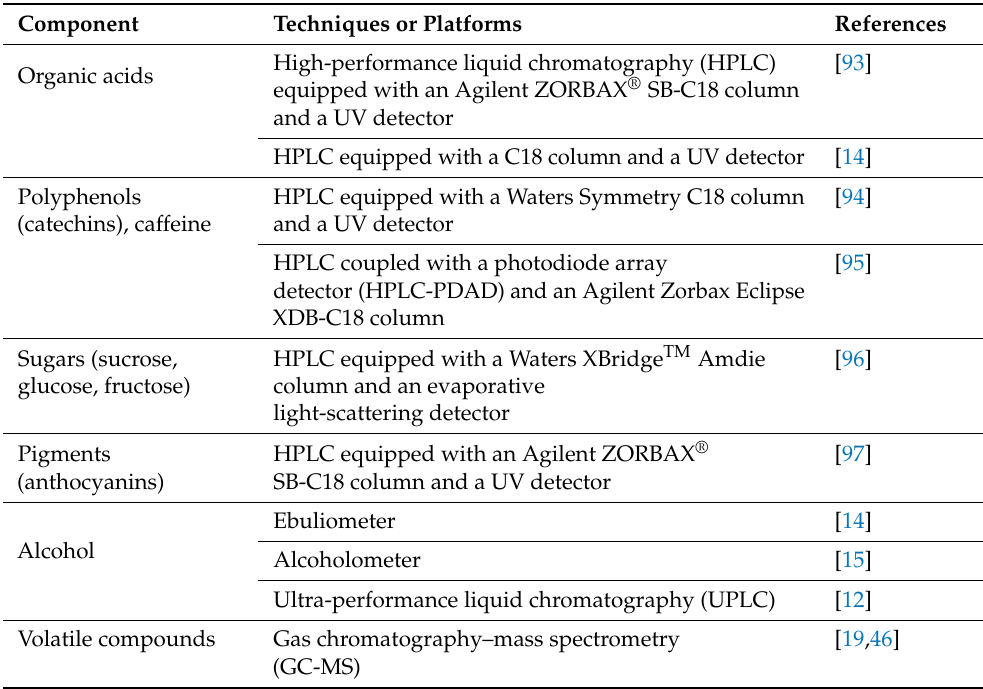
Table 3. Techniques or platforms widely used to determine bioactive compounds in kombucha prod-